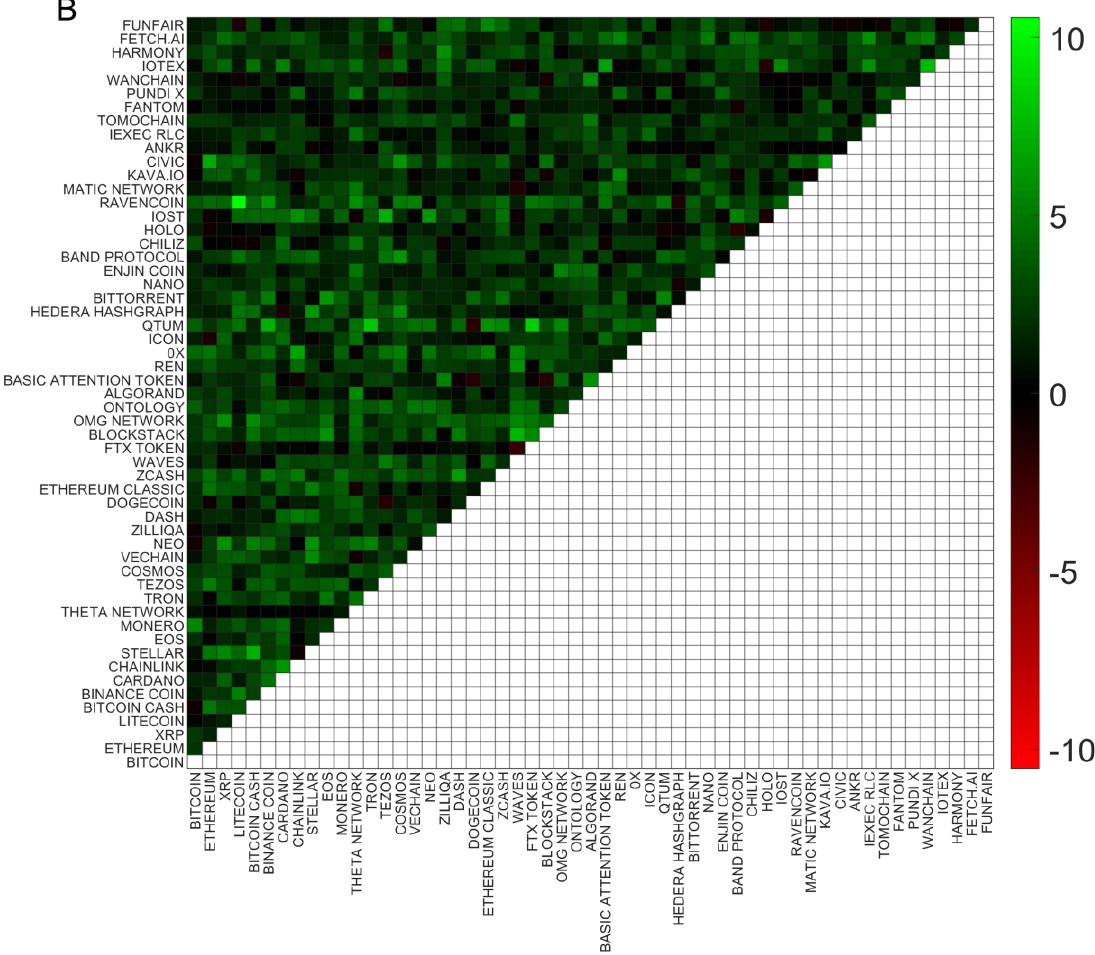
Fig. 7B. Asynchronous trading condition with lower frequency of trading for the smaller market capital cryptocurrency. Pixel values mean the same as in 7A, except that the larger market capital cryptocurrency in the corresponding pair is traded at a lower